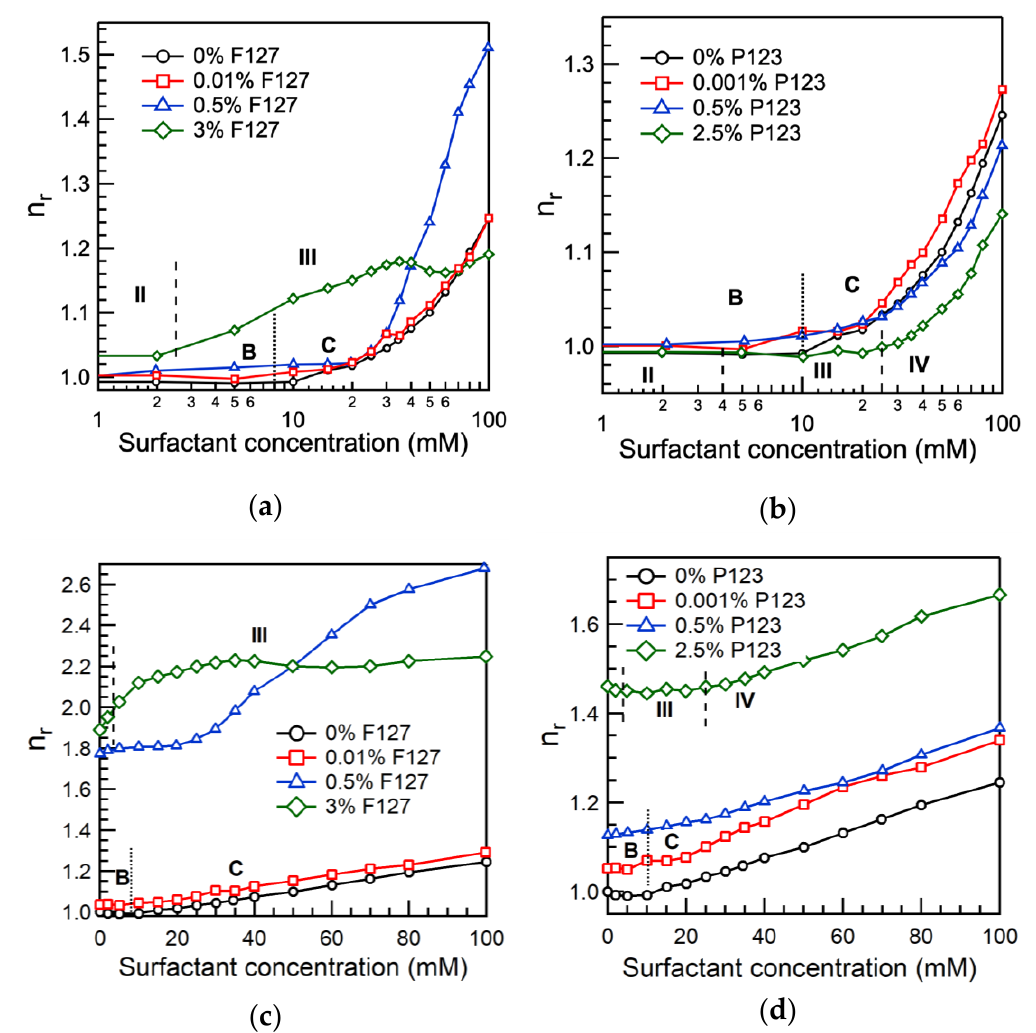
Figure 4. Relative viscosity as a function of surfactant concentration in the aqueous solution in the absence of added polymer and in the presence of ( a , c ) 0.01%, 0.5%, or 3% Pluronic F127 (20 ° C) or ( b , d ) 0.001%, 0.5%, or 2.5% Pluronic P123 (18.5 °C). In Figure 4a,b, the relative viscosities ( η r = η / η 0 ) are calculated considering η 0 as the viscosity of the corresponding aqueous Pluronic solution. In Figure 4c,d, relative viscosities are calculated considering η 0 as the viscosity of plain water. The vertical dotted lines indicate SDS concentration regions that correspond to different stages of the PEO-PPO-PEO block copolymer and ionic surfactant interactions, as described in the Results and Discussion Section and depicted in Figure 6.